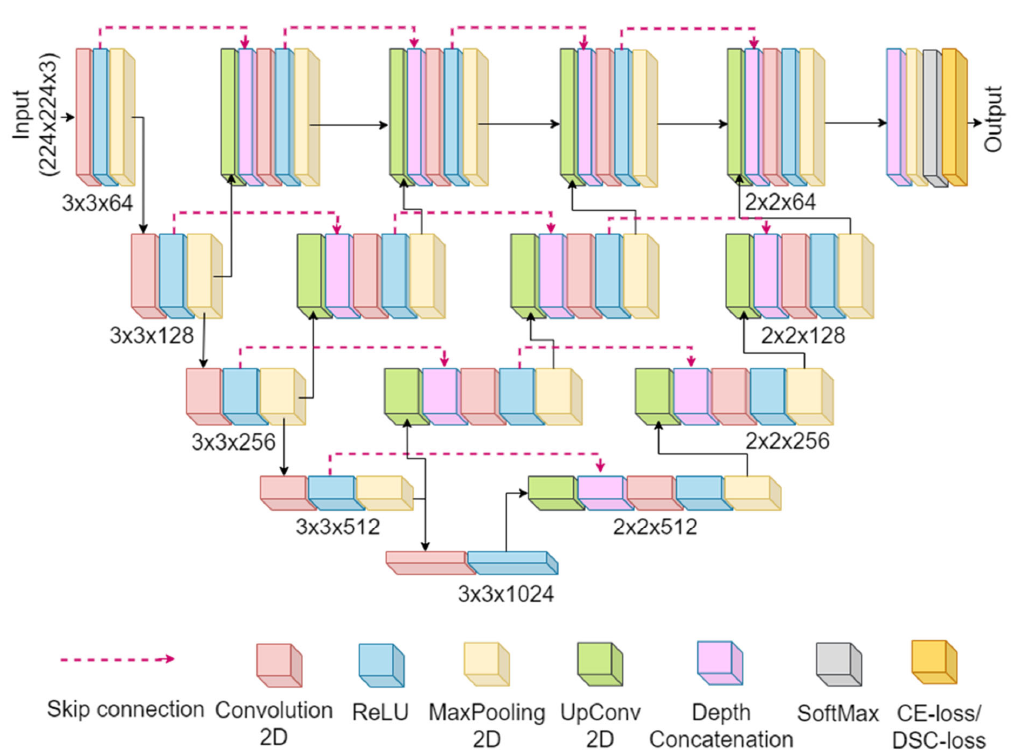
Figure 4. UNet+ Figure 4. UNet+ architecture.